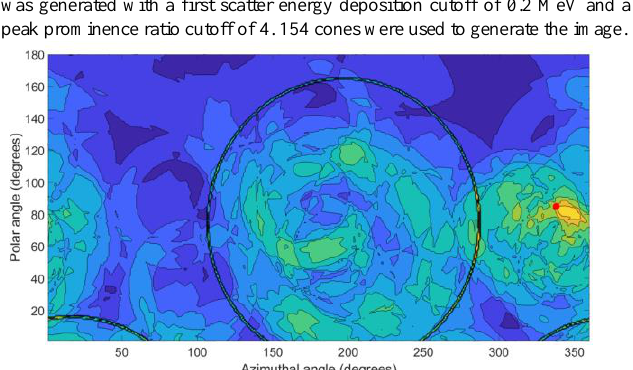
Fig. 13. Improved neutron image of a point source located at (338, 85). The initial guess vector points towards (318,76). The image was made with an initial energy deposition cutoff of 0.5 MeV, a second scatter criterion prominence ratio of 6.5, and 48 cones. The guess vector region was set to 60° azimuthal width and 20° polar height.